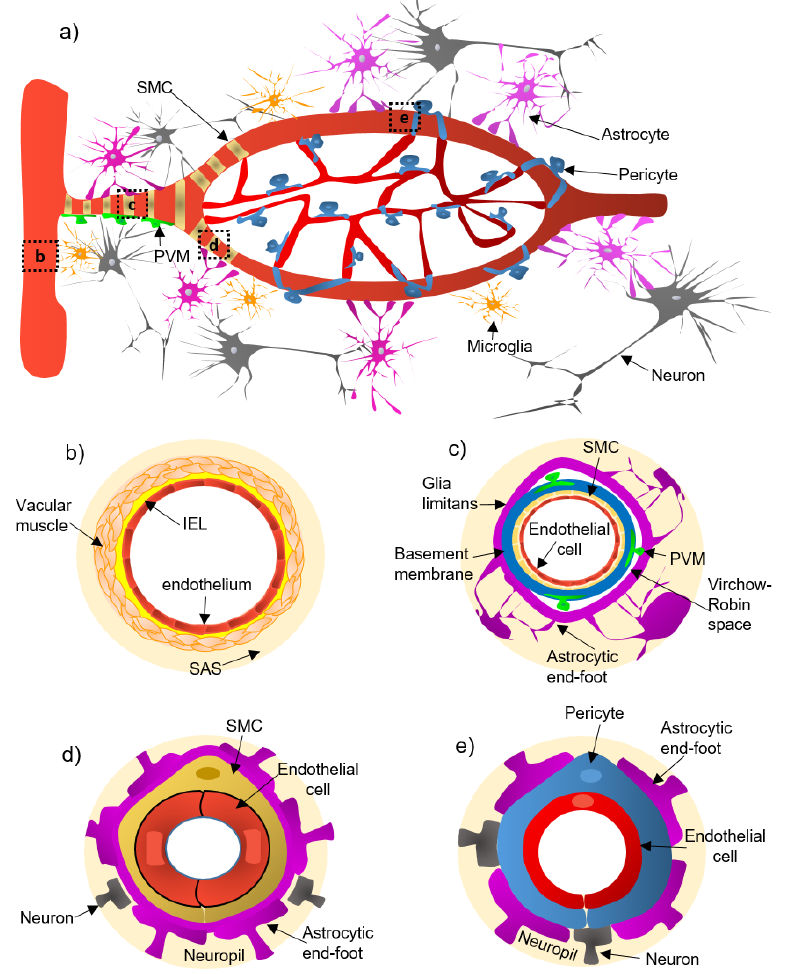
Figure 1. Illustration of the constitutive cellular elements of the neurovascular unit (NVU) along the entire brain vasculature. Panel ( a ) shows a panoramic view of the vascular tree. Panels ( b – e ) depict the different levels of the vascular tree. Pial arteries (panel ( b )) run along the brain surface and penetrate the parenchyma, narrowing and branching into penetrating arterioles (panel ( c )), which form the intraparenchymal arterioles (panel ( d )), and ultimately give rise to capillaries (panel ( e )). Abbreviations: IEL, internal elastic lamina; PVM, perivascular macrophage; SAS, the subarachnoid space; SMC, smooth muscle cell.